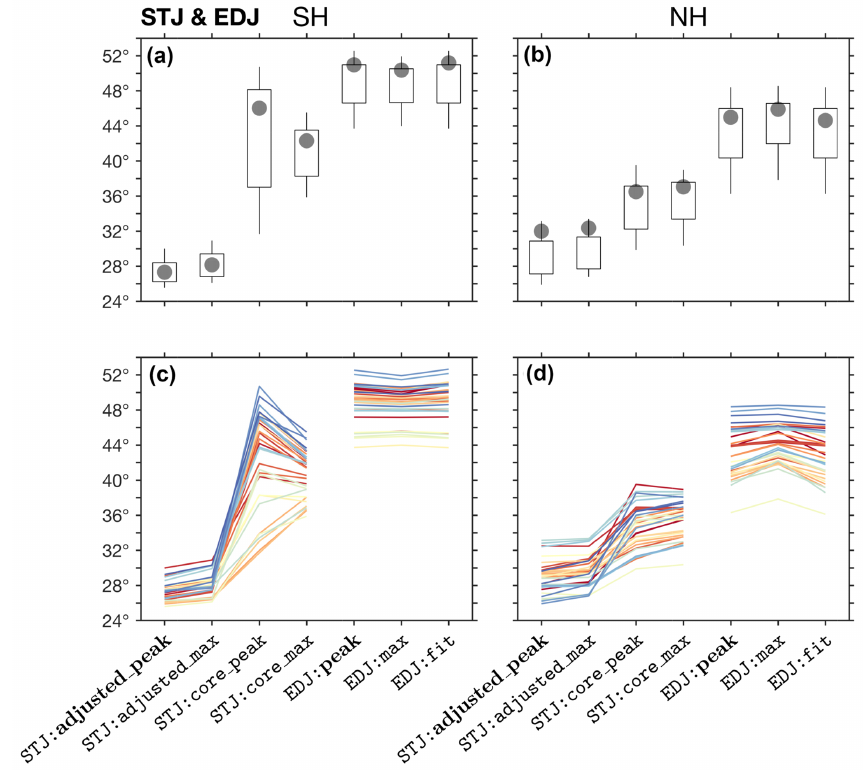
Figure 15. As in Fig. 12 for the STJ and EDJ metrics.